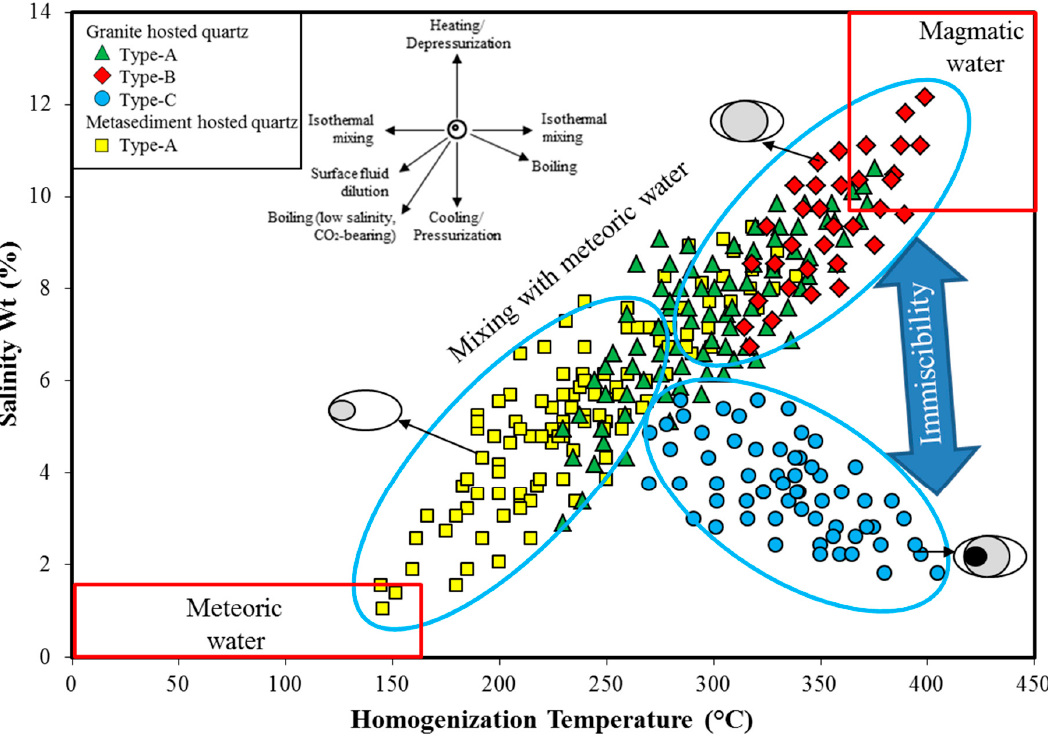
Figure 14. Plot of homogenization temperature (Th) versus salinity of fluid inclusion data from the Tagu Sn–W deposit with typical trends of fluid evolution patterns. [58].